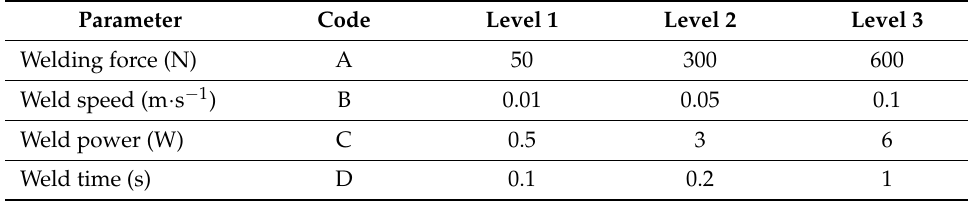
Table 1. Parameter values at each level used for PcBN design of experiment (DOE).